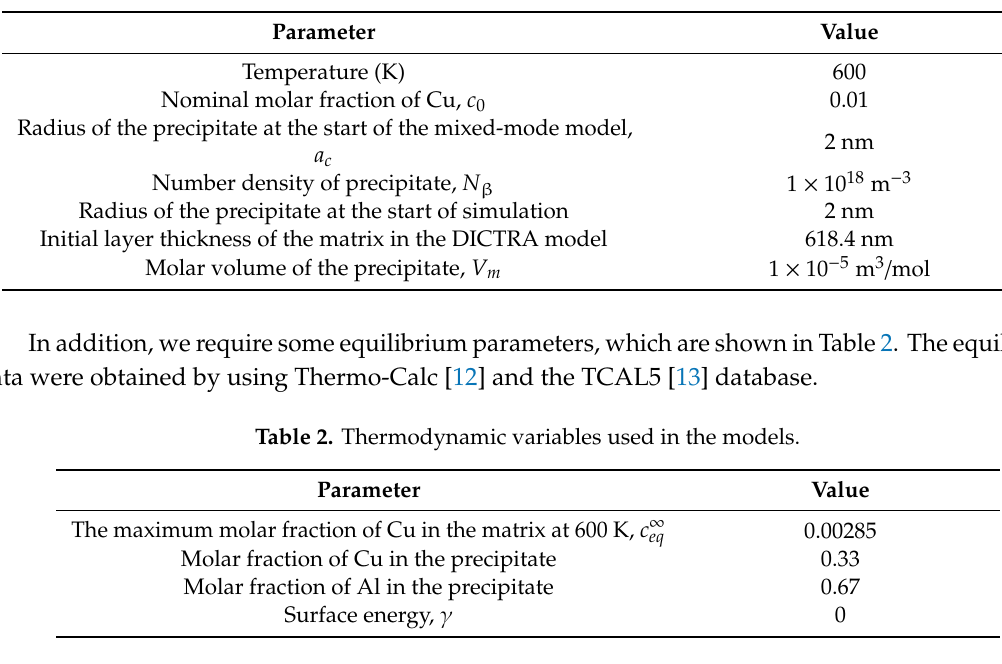
Table 1. Parameters defining the growth of θ -Al 2 Cu precipitates in the Al–Cu system.